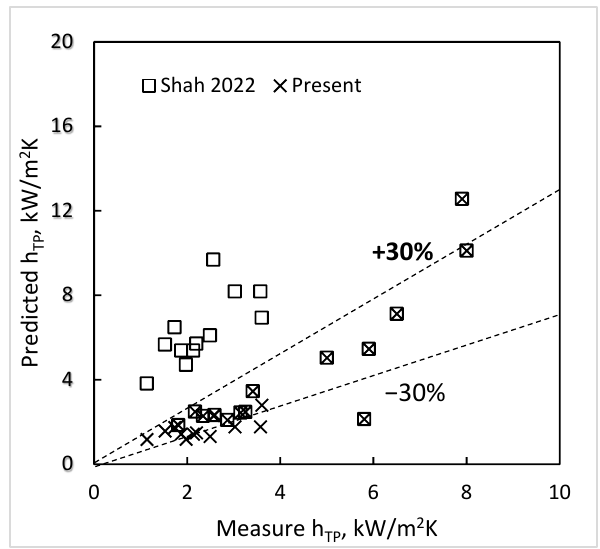
Figure 1. Data for x ≥ 0.99 compared to the present and the Shah [1] correlation. The one data point of Azzolin et al. [27] for HFE 7000 in a rectangular channel has a deviation of − 63% with the present as well as the Shah [1] correlation. It is to be noted that all their data at all levels of quality are similarly underpredicted by almost all correlations. It indicates that these data are unusually high.